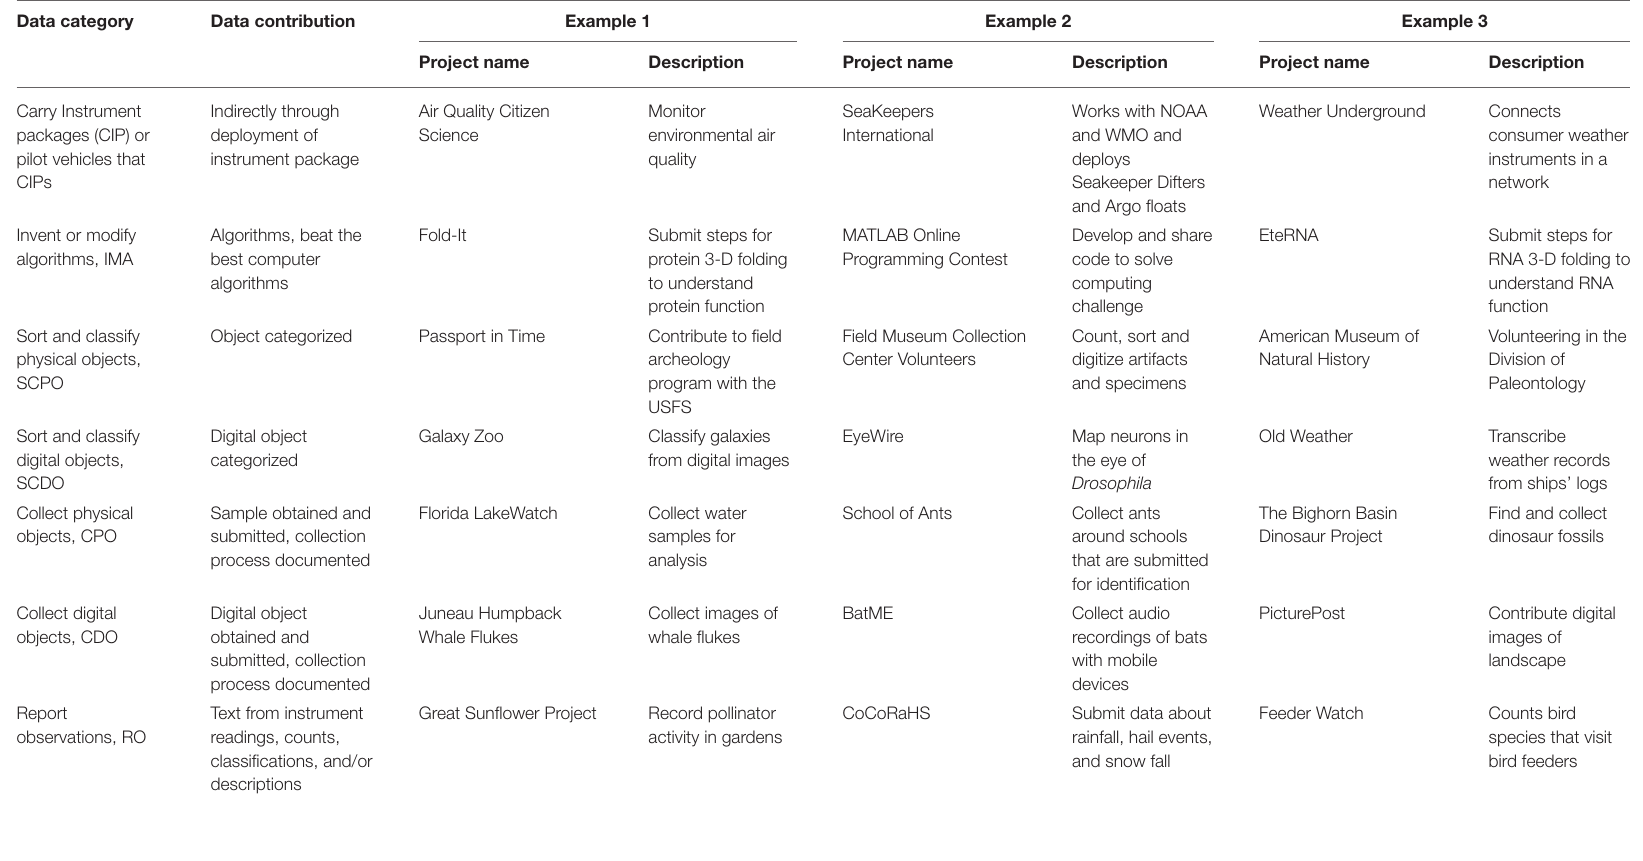
TABLE 1 | Seven basic types of data contributions made to citizen science projects with